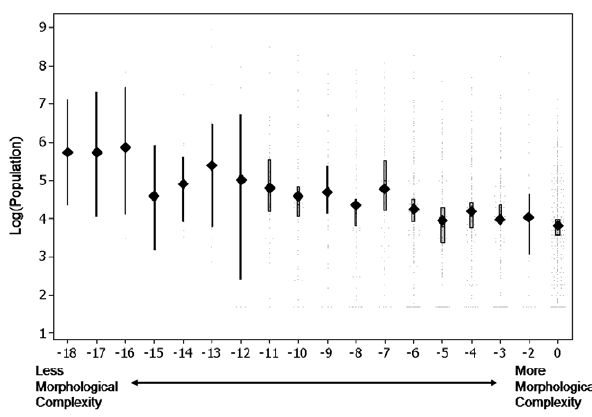
Figure 3. Languages spoken by more people have simpler inflectional morphology. X-axis scores represent a measure of lexical devices compared to the use of inflectional morphology. Filled symbols represent population means for languages with a given complexity score; bars show 95% confidence intervals of the median. Bar width is proportional to sample size for each score.